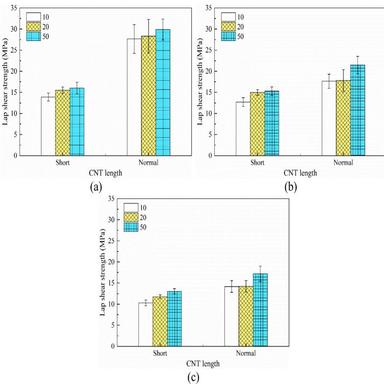
Lap shear strenths of CNT reinforced epoxy composites with different CNT geometries: (a) 0.5%; (b) 1%; (c) 2% CNT fractions.